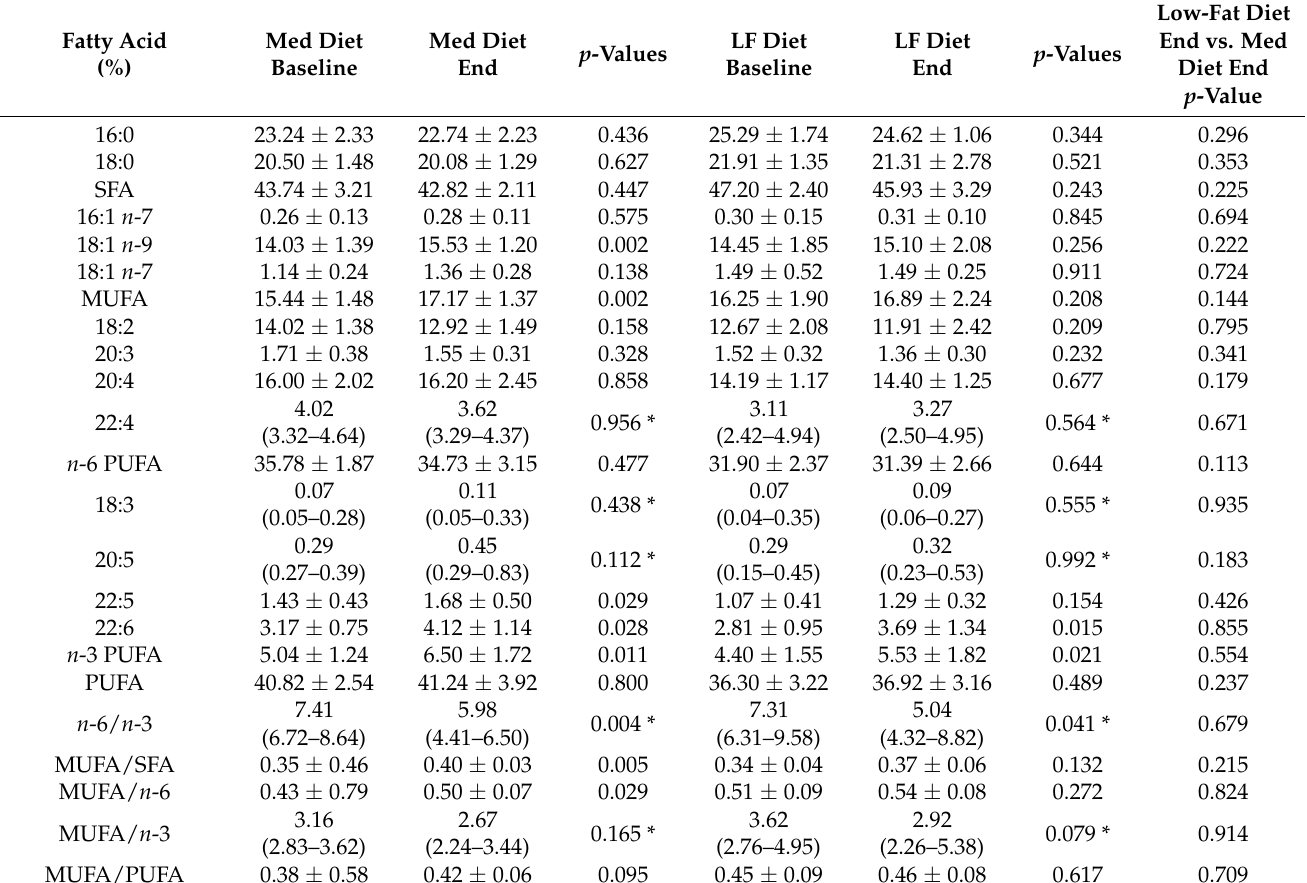
Table 4. Erythrocyte phospholipid fatty acid composition in NAFLD patients at baseline and after the dietary